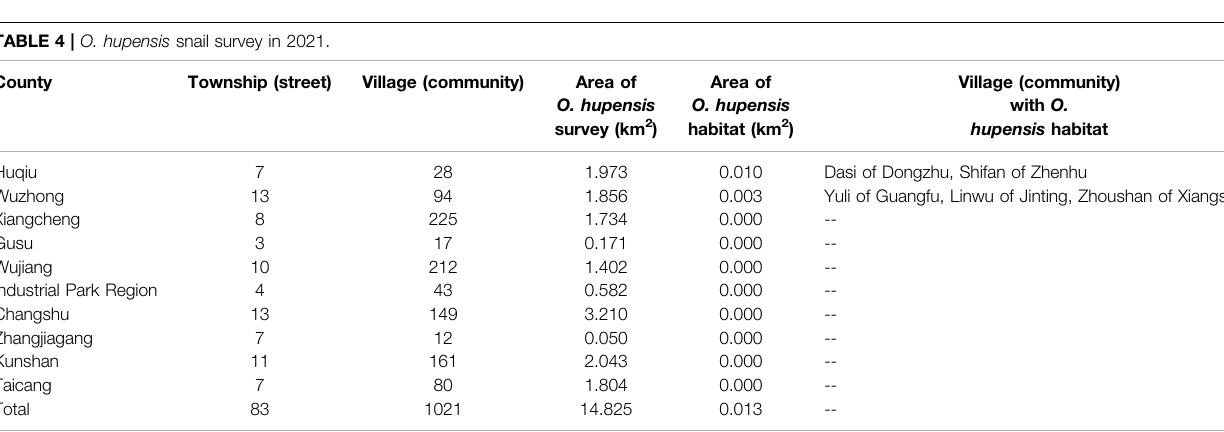
TABLE 4 | O. hupensis snail survey in 2021.